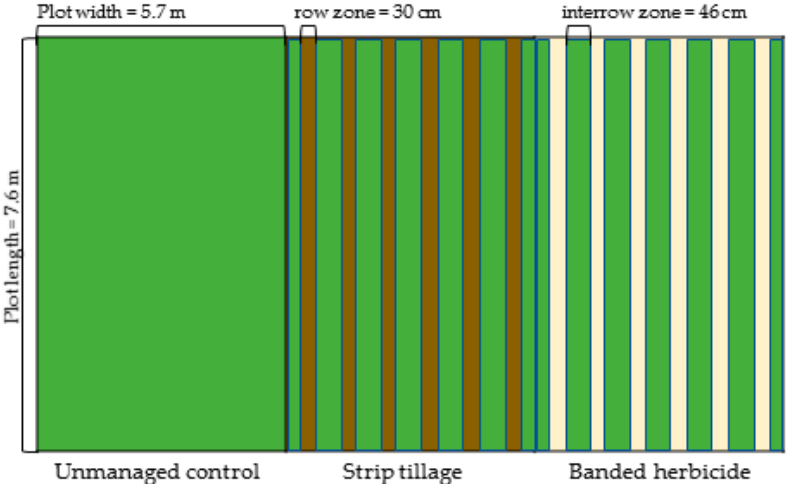
Figure A1. Plot layout and design within a single replication.